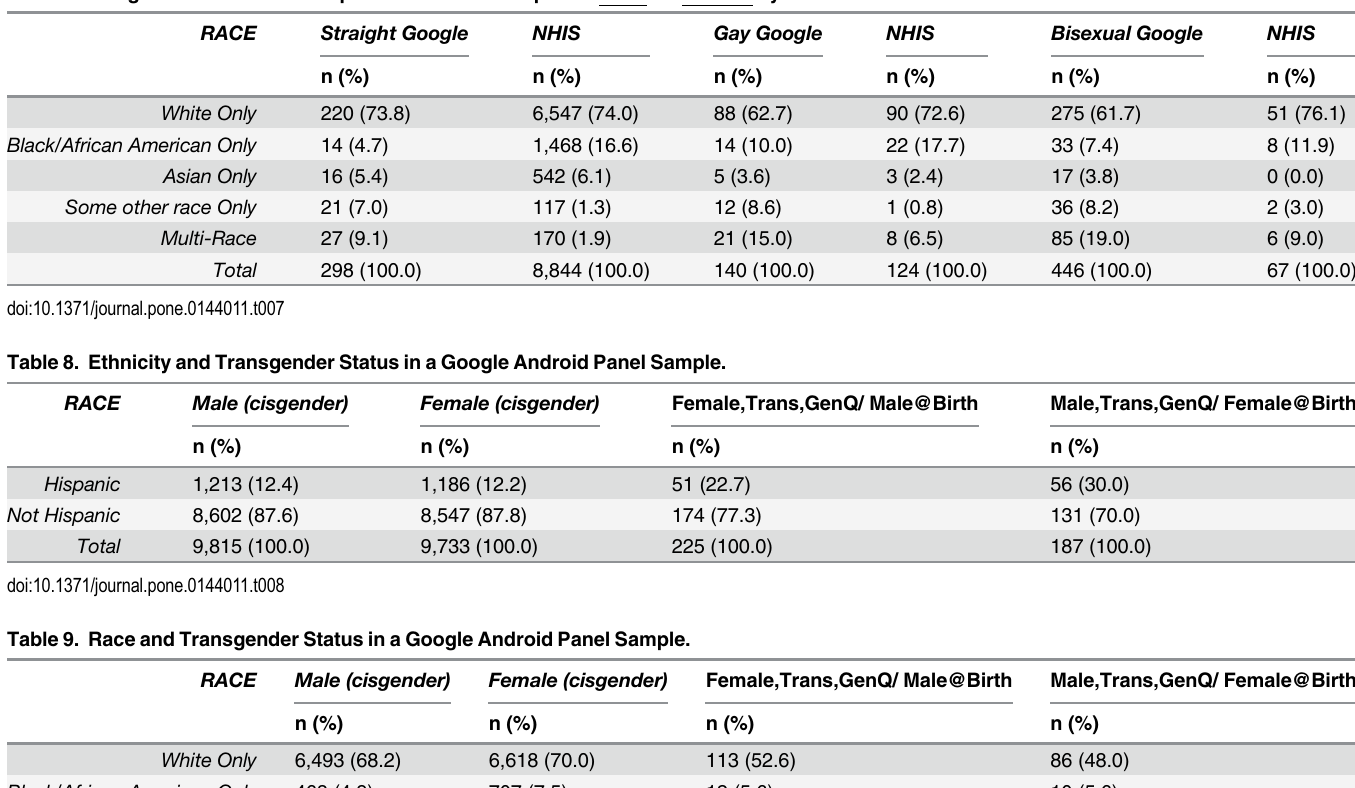
Table 7. Google Android Panel Samples and the NHIS Reported Race for Women by Sexual Orientation.